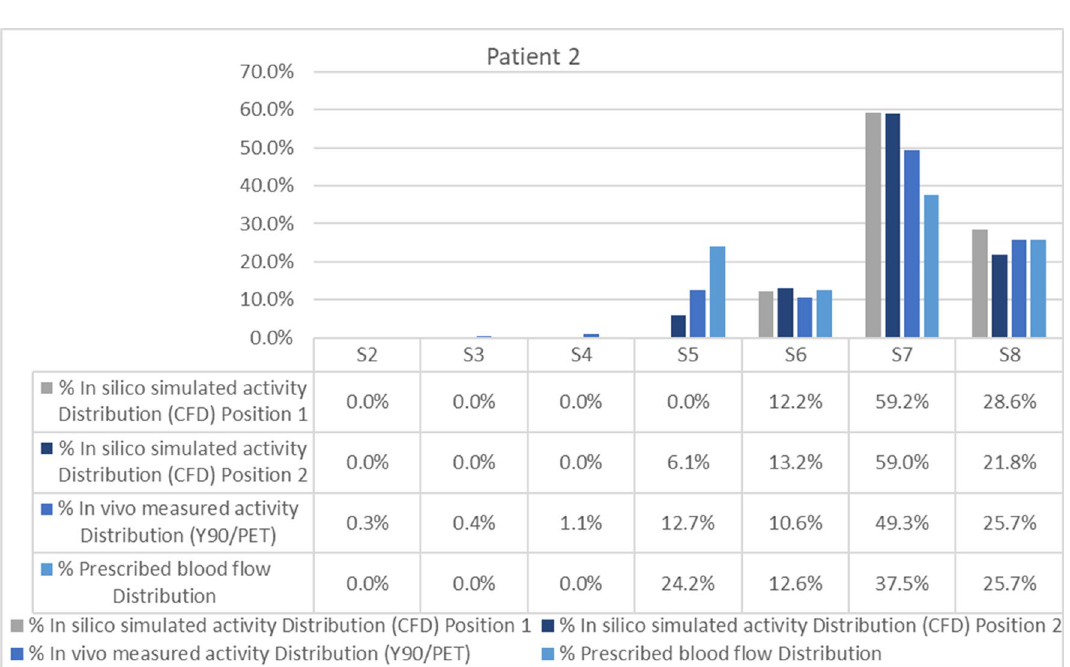
Figure 5. Segment-to-segment calculated activity distribution (CFD), measured activity distribution ( 90 Y/PET), and prescribed blood flow split for Patient 1.